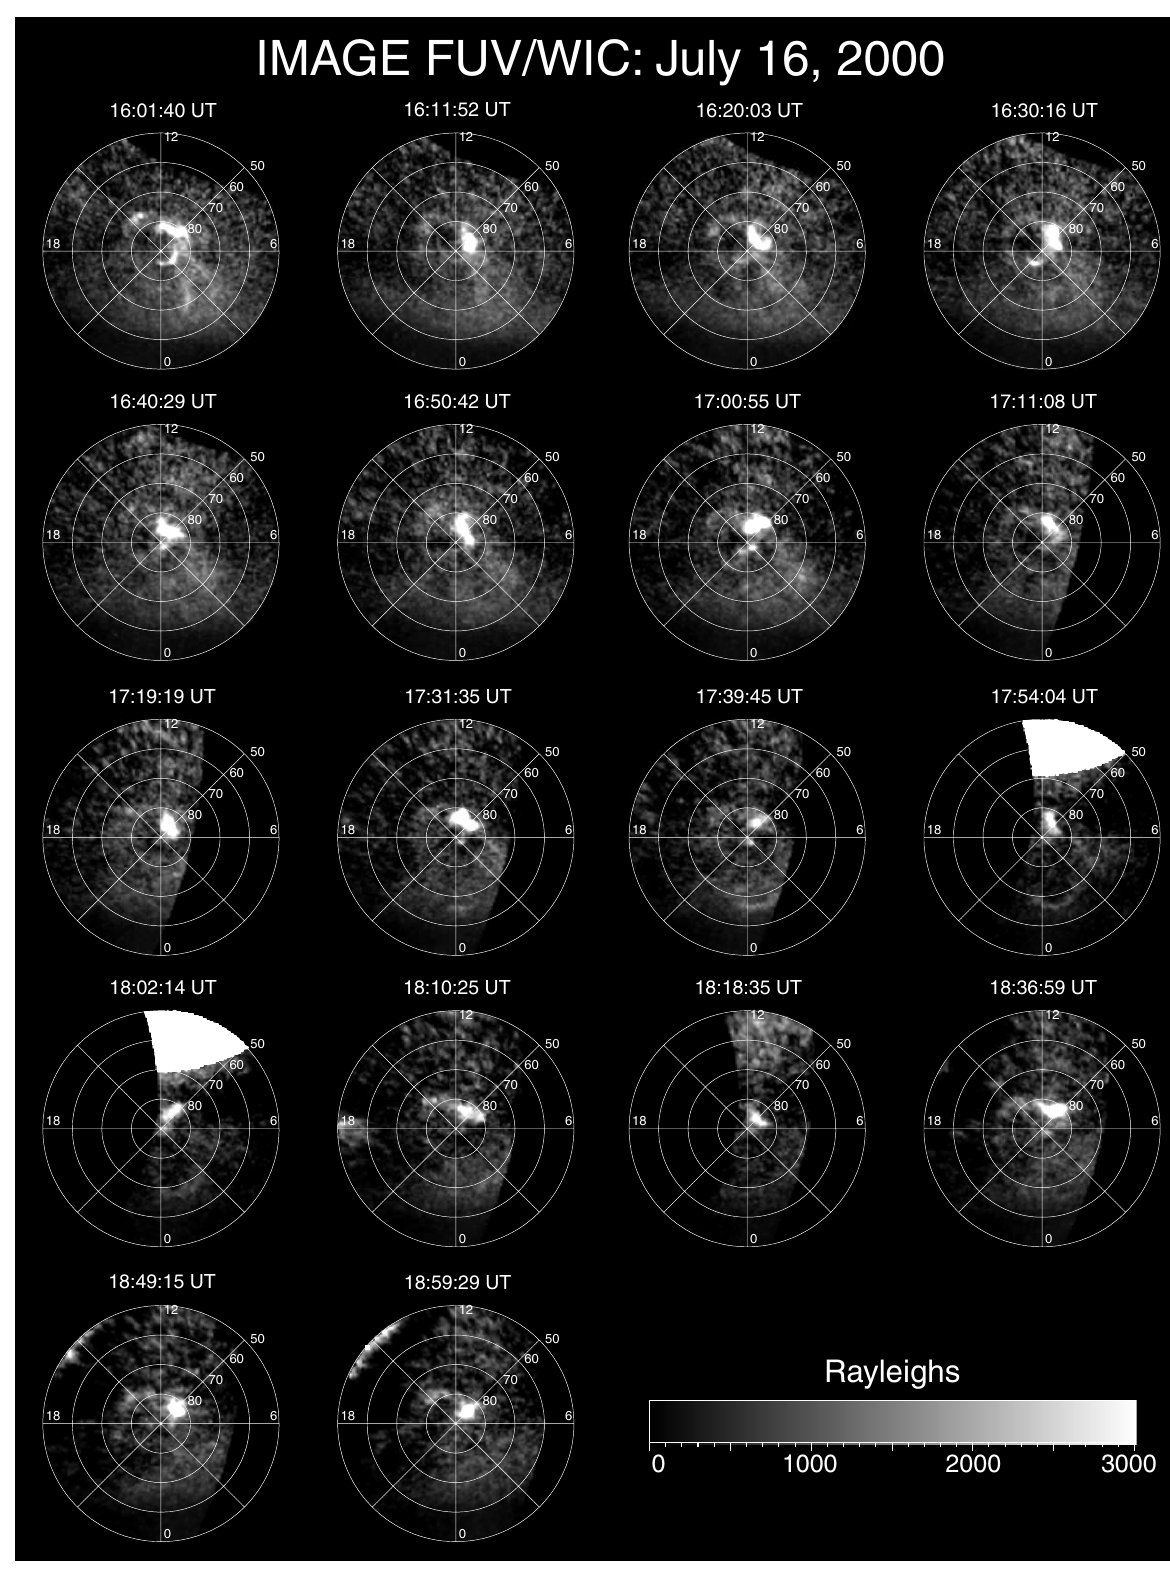
Fig. 4. Auroral emissions in AACGM MLT-MLAT coordinates observed by IMAGE FUV/WIC on 16 July 2000, between 16:00 UT and 19:00